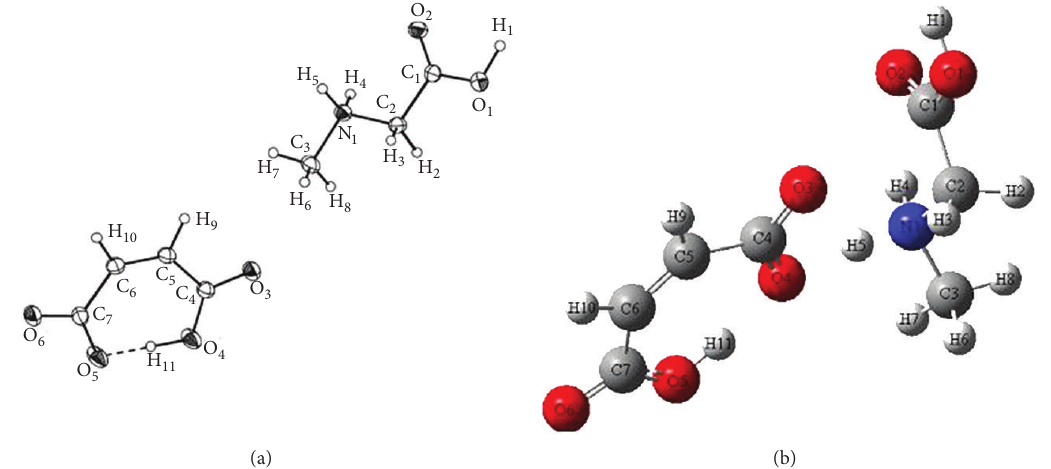
geometric structure of the sarcosine-maleic